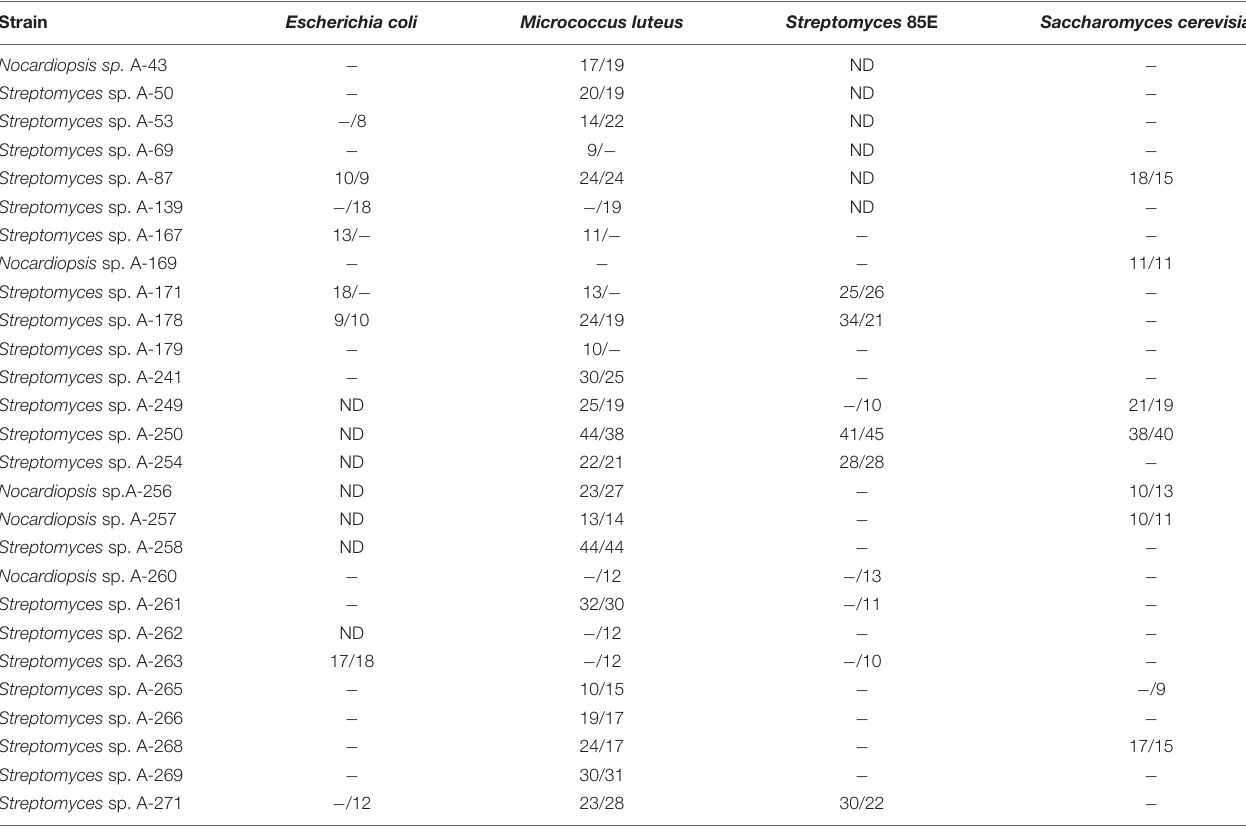
TABLE 3 | Antibiotic activities of ethyl acetate extracts of the